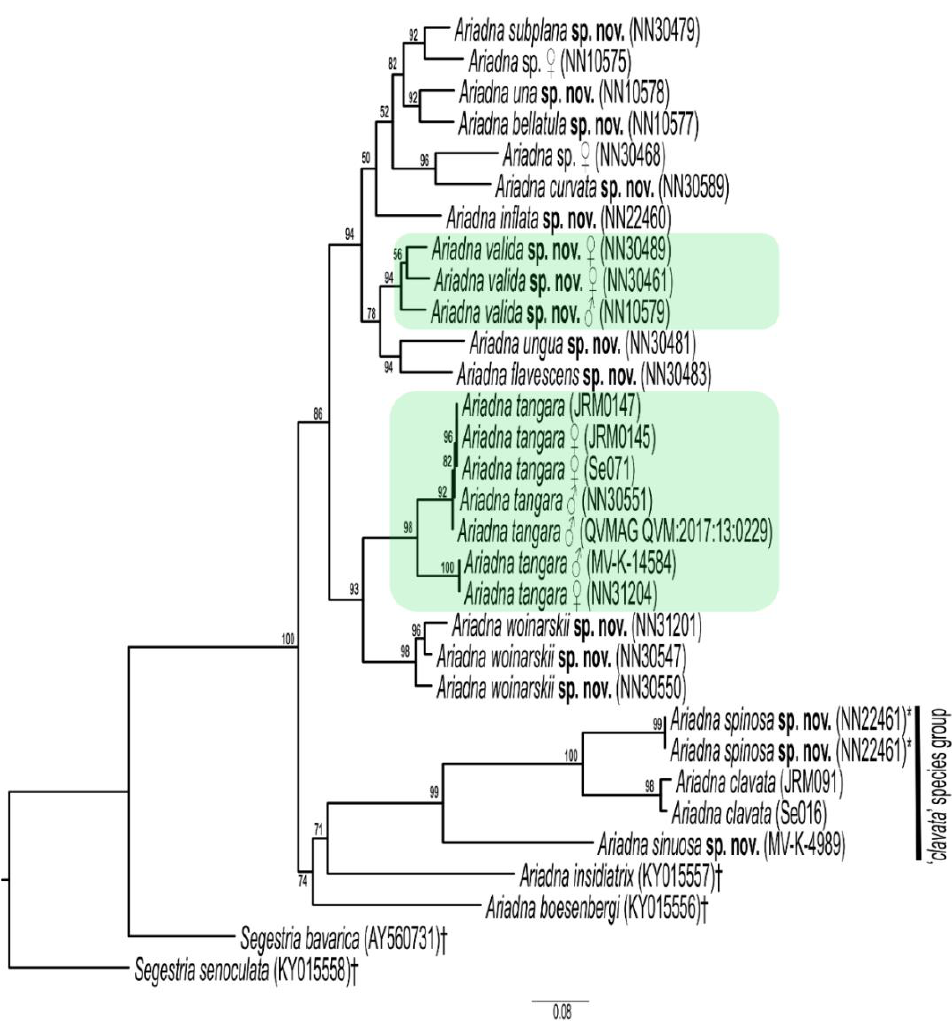
Figure 2. Maximum likelihood tree of the mitochondrial 12S gene of all 27 Ariadna sequences used and two outgroup taxa. Included are 17 Ariadna species, including eleven species newly described here. Bootstrap support values greater than 50% are shown at each node. Details for all new sequences are available in Table 1. Undescribed species from our study are indicated where only a female is known ( ♀ ), and we indicate where we have both males ( ♂ ) and females ( ♀ ). GenBank accessions are indicated (†), and we also indicate (green highlight) where we have both males and females of a species. * Indicates a specimen sequenced twice independently. Table 1. Specimens sequenced in the current study, for all relevant and new species, with GenBank accession codes for COI and 12S. Species treated in this study are presented in the order they appear in this manuscript.